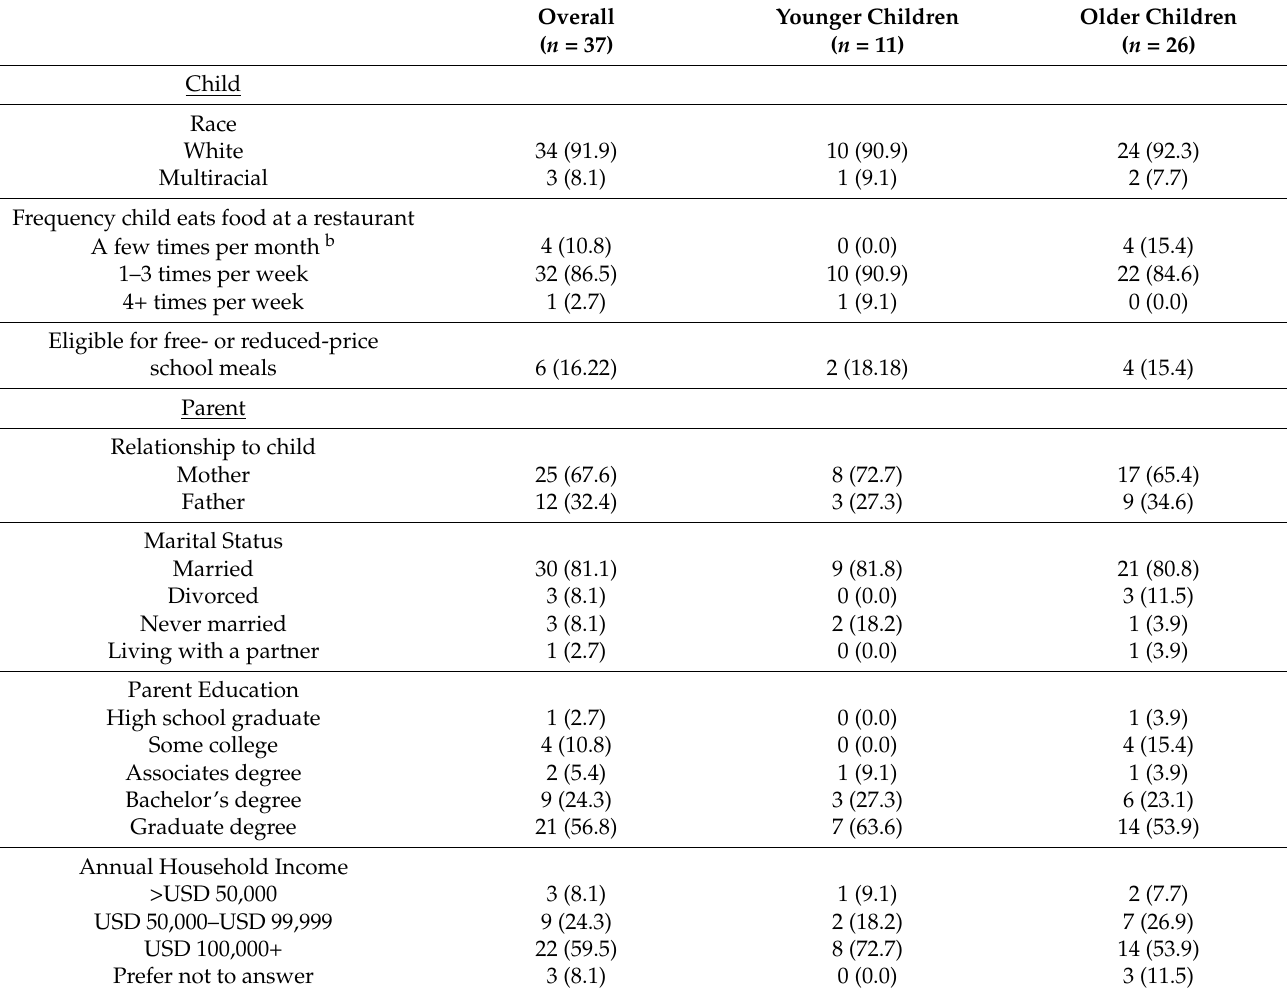
Table 1. Demographic characteristics of participating families a